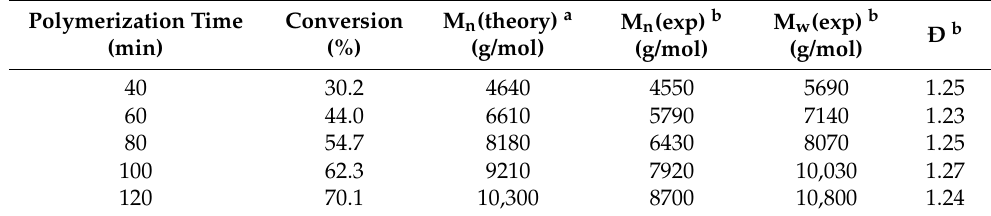
Table 1. Kinetic and molecular weight data for the RAFT polymerization of acrylamide (([M] 0 /= 12%, [CTA] 0 /[AIBN] 0 =